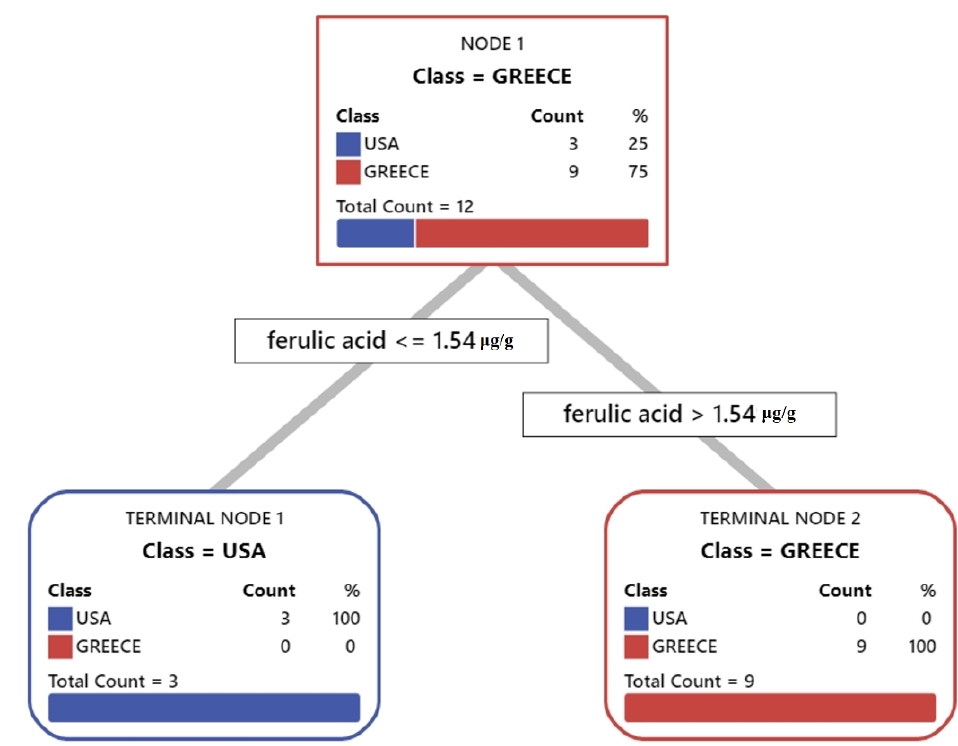
Figure 4. Optimal decision tree diagram using predictive analysis for phenolic and tocopherol concentration of almond samples originating from Greece and USA.